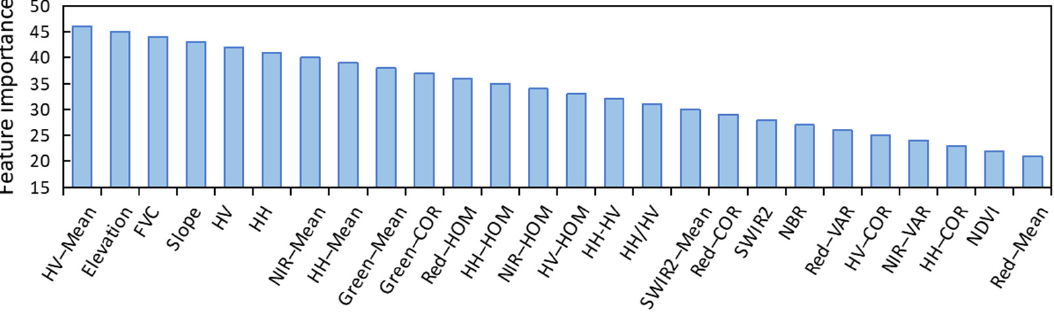
Figure 4. Feature importance ranked by the SHCE feature selection algorithm. The importance of each of the selected 26 features was obtained by subtracting 47 from its ranking order.